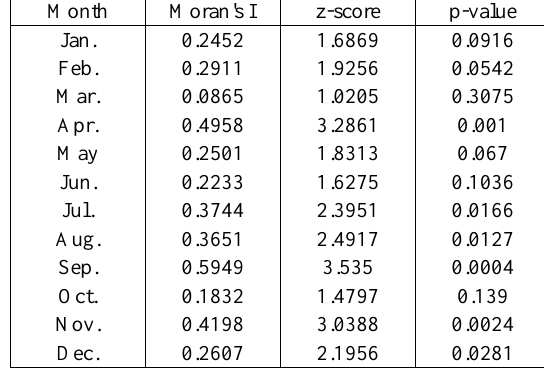
Figure 3. Monthly average AOD in Jiangsu Province from